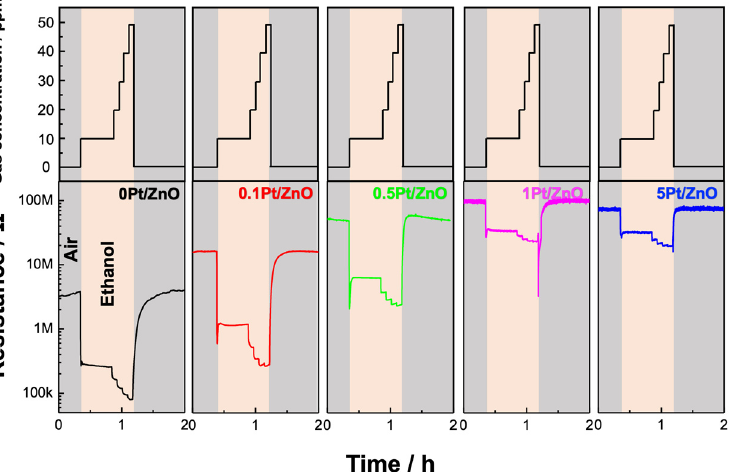
Figure 6. Response transients to ethanol at 350 °C under dry conditions for the device using 0, 0.1, 0.5, 1, and 5% Pt-loaded ZnO NCs. The upper panel indicates the gas concentration during the measurements.